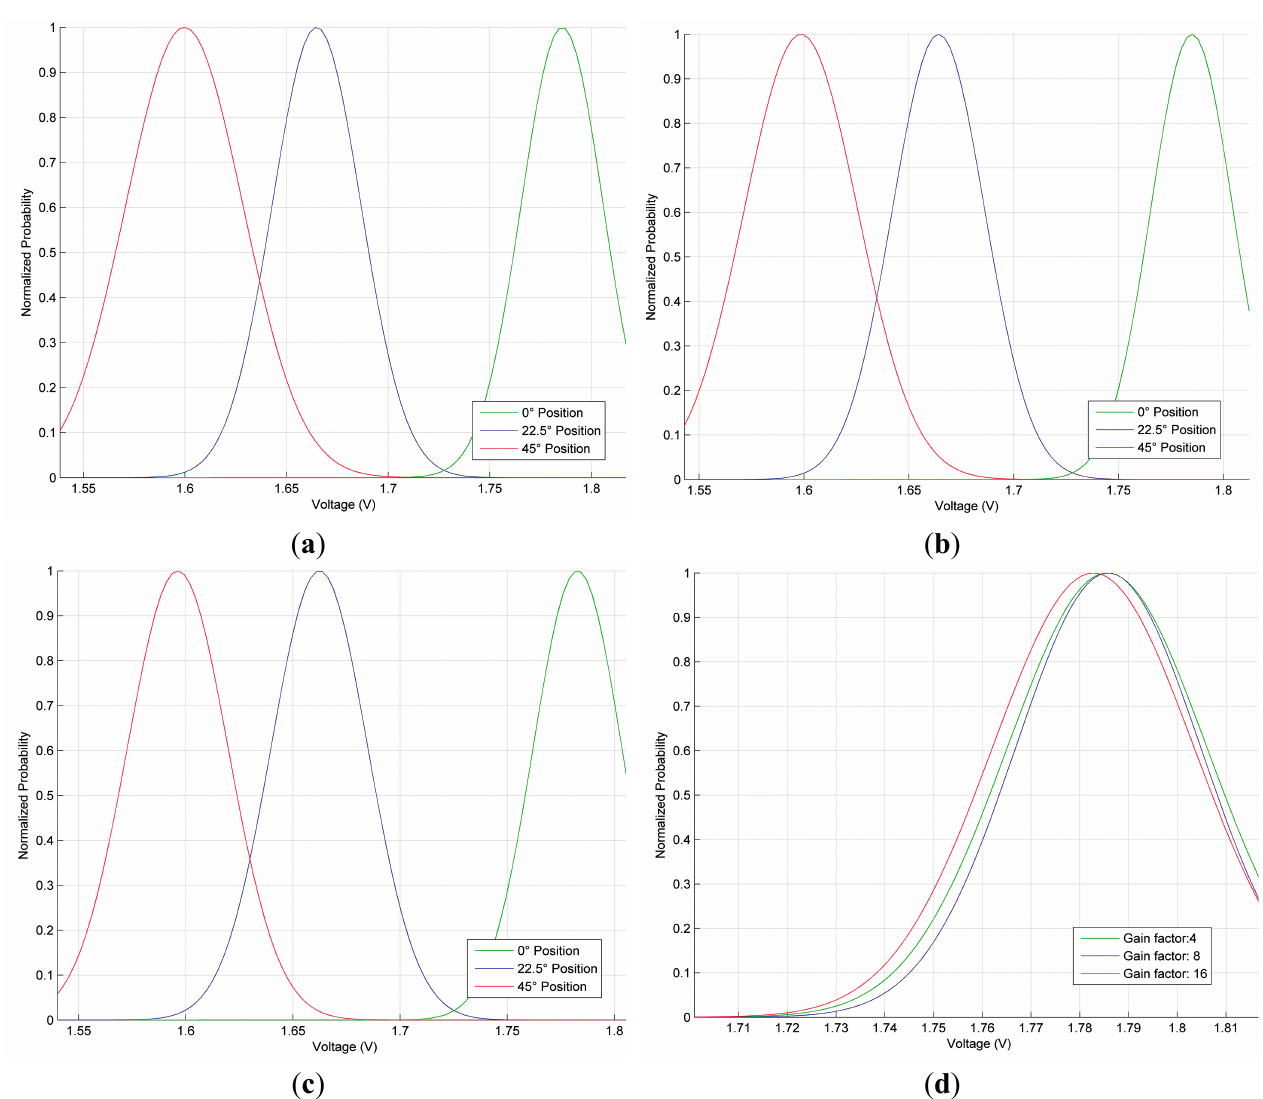
Figure 7. GF Effects in the GMM. ( a ) GF = 4 ( b ) GF = 8 ( c ) GF = 16 ( d ) GF Effects on the GMM of 0